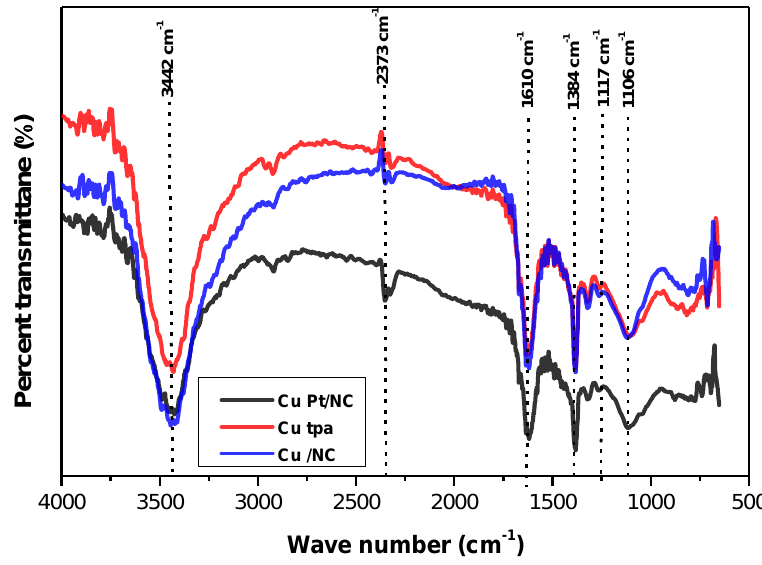
Figure 1. FTIR of Cu / NC, CuPt / NC, and Cu-tpa metal-organic frameworks (MOF).